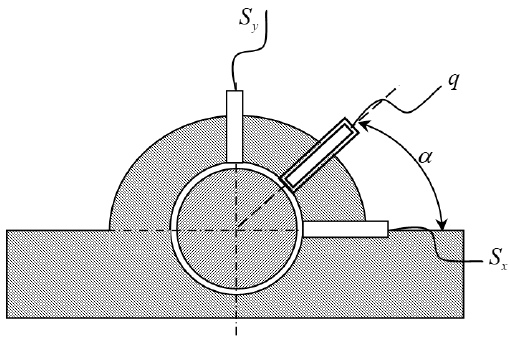
Figure 3. Simplified diagram of a bearing with mounted sensors. In Figure 3,